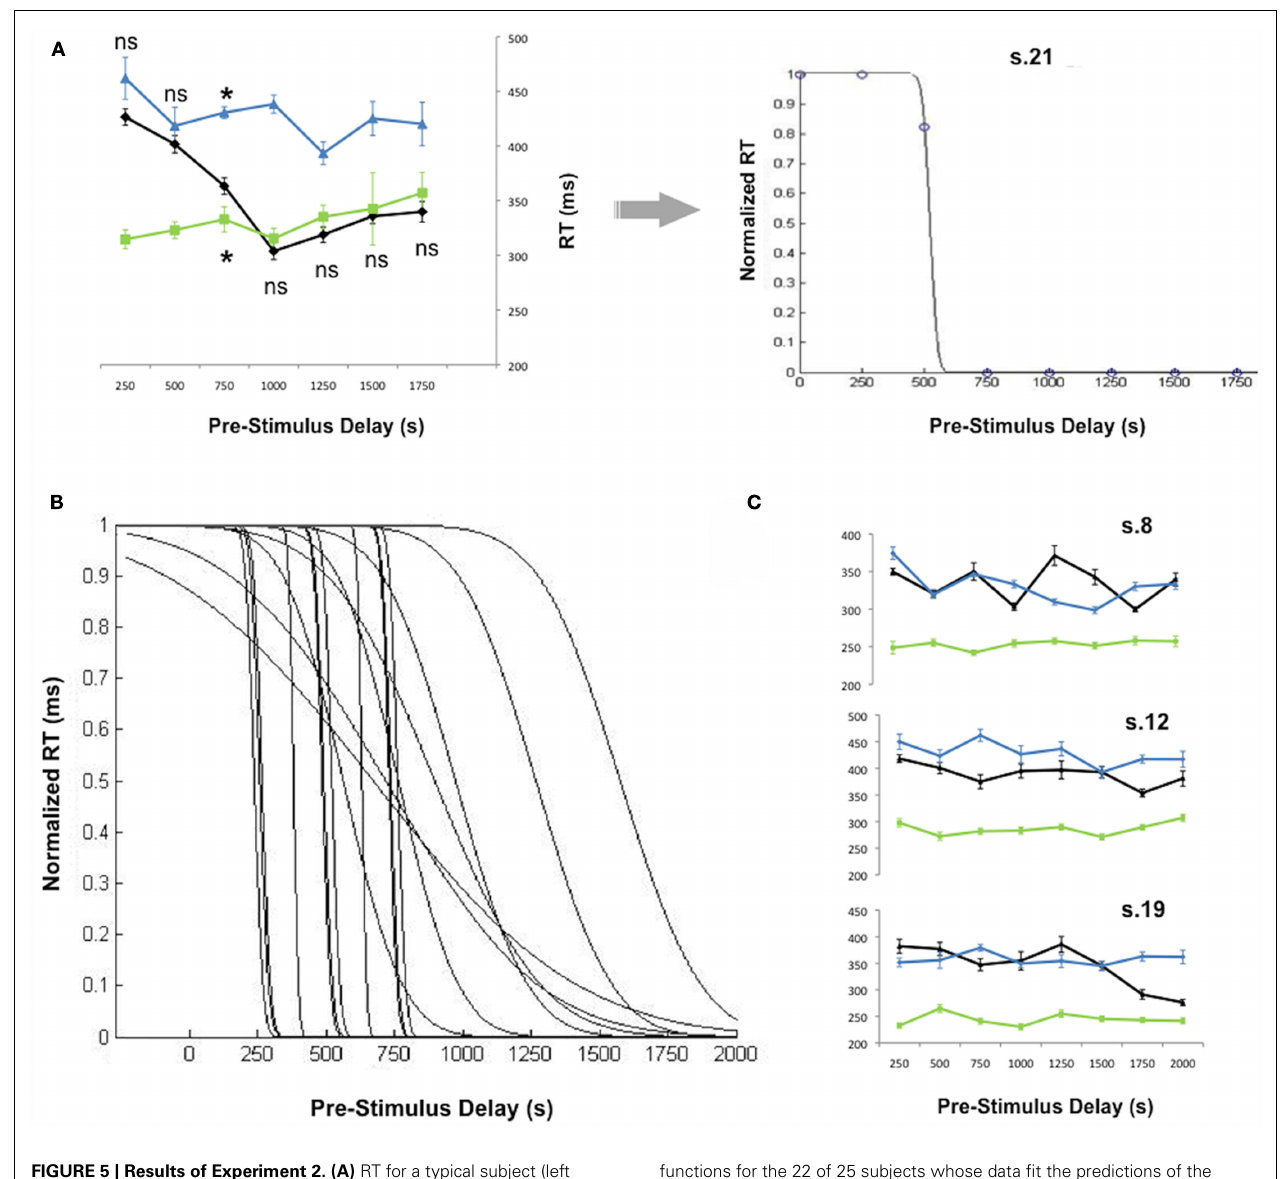
FIGURE 5 | Results of Experiment 2. (A) RT for a typical subject (left side).White_cross_no_cue RT normalized according to both red_cross_no_cue and red_cross_long_CTOA conditions for the same subject (right side). Data are fitted by a logistic function which best represents the switch from one state to another. (B) Fitted logistic